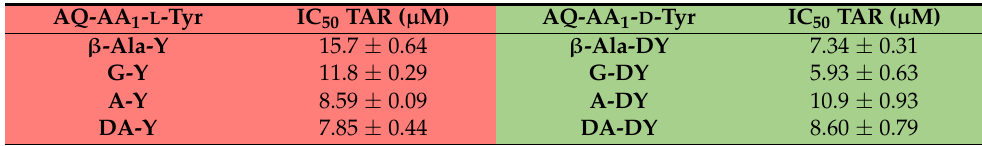
Table 1. Inhibition of NC-mediated melting of TAR by AQ-AA 1 - L -Tyr (red columns) and AQ-AA 1 - D -Tyr (green